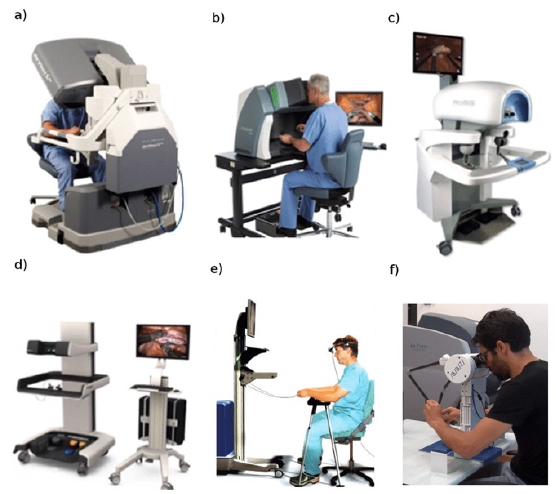
Figure 4. From Elek et al. (2019) [16]. Various virtual reality robotic surgery simulators. ( a ) Da Vinci Skills Simulator. ( b ) dV-Trainer. ( c ) Robotic Surgery Simulator. ( d ) Robotix Mentor. ( e ) SEP Robot. ( f ) Actaeon Robotic Surgery Training Console.